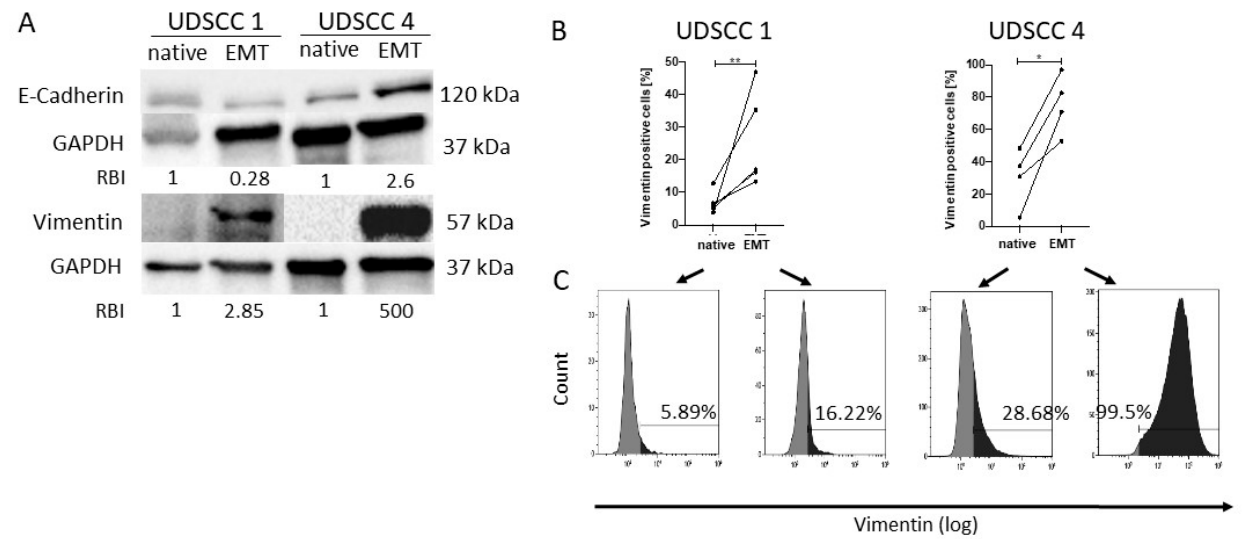
Figure 1. Confirmation of epithelial to mesenchymal transition (EMT) induction. UDSCC1 and UDSCC4 cells were treated with StemXVivo EMT-inducing media supplement for 5 days to induce EMT. ( A ) Western blots were performed for detection of E-cadherin and vimentin expression of native and EMT-induced UDSCC1 and UDSCC4 cell lines. Note the increased expression of vimentin in both cell lines after EMT induction, while E-cadherin expression was increased in UDSCC4 cells but decreased in UDSCC1 cells. Relative band intensities (RBIs) were calculated between E-cadherin and GAPDH or vimentin and GAPDH. The blot is representative for n = 3. Original blots can be found in Figure S1. ( B ) Flow cytometry of native and EMT-induced cells revealed significantly higher vimentin levels in EMT cells. P -values were determined with the Mann–Whitney test, with * p < 0.05, ** p < 0.01. ( C ) Representative flow cytometry histograms depicting vimentin expression of native and EMT-induced UDSCC1 and UDSCC4 cell lines. Note that Vimentin expression was increased after treatment with StemXVivo EMT-inducing media supplement, especially for